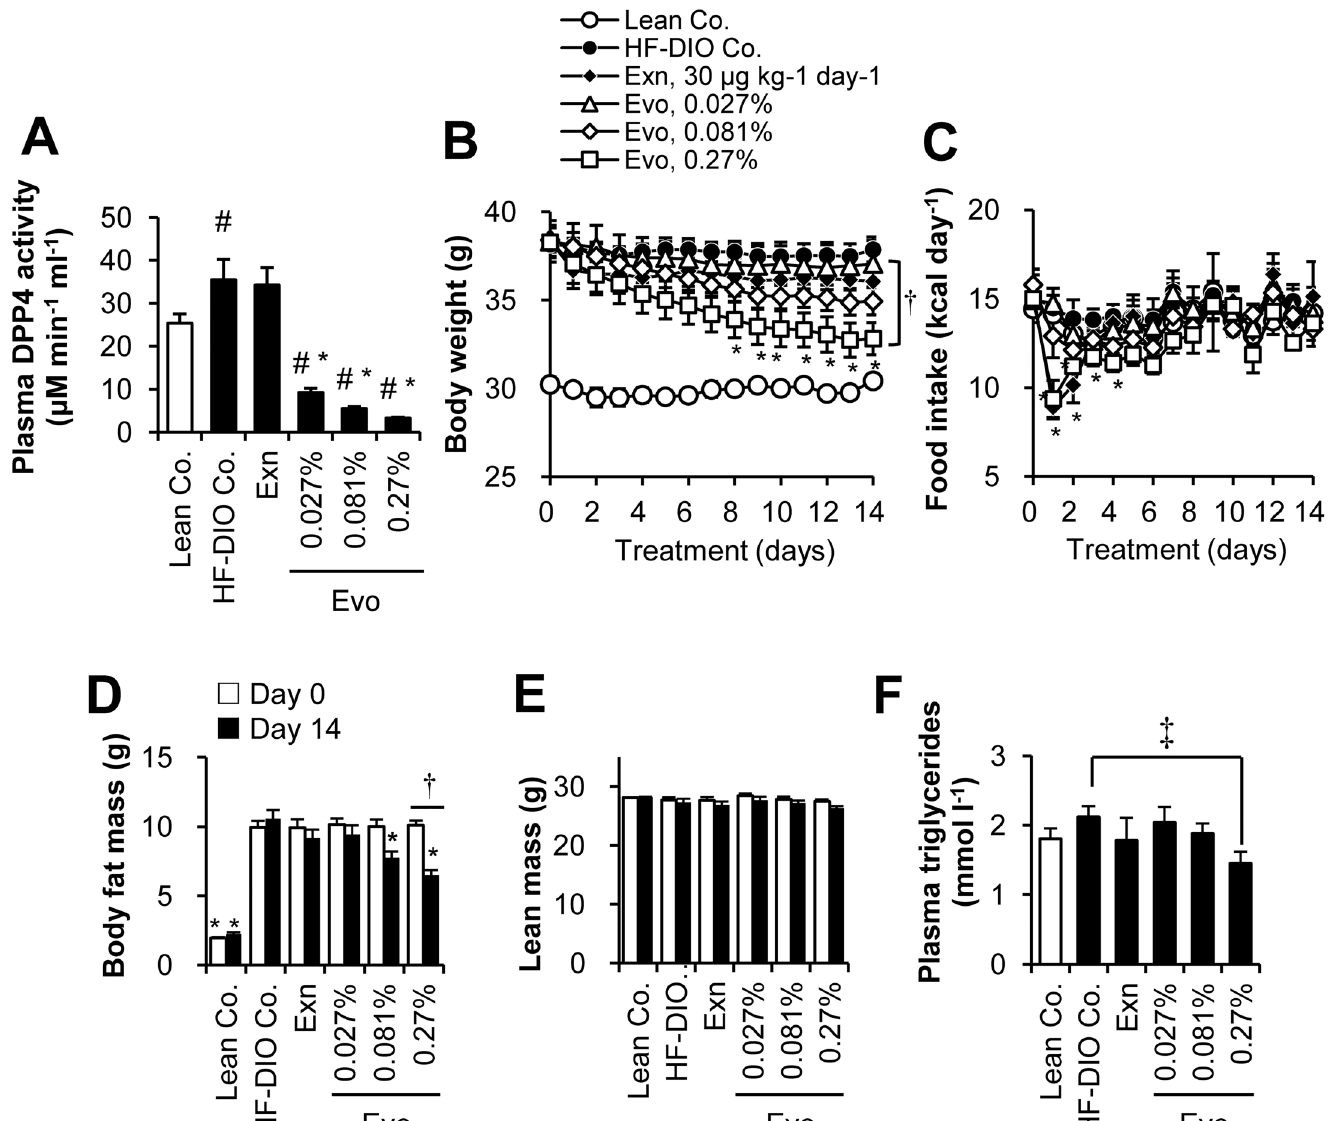
Fig 2. Two-week treatment of evogliptin decreased whole body fat mass in obese mice. After HF-DIO mice were treated with exenatide (30 μ g kg -1 , once daily, s.c.) or evogliptin at 0.027%, 0.081%, or 0.27% (w/w) for 2 weeks, (A) plasma DPP4 activity, (B) body weight, (C) energy intake, (D) whole body fat mass, (E) lean body mass, and (F) plasma triglycerides levels were determined (n = 8/group). #, P < 0.05 vs. lean control and * , P < 0.05 vs. HF-DIO control by one-way ANOVA; † , P < 0.05 vs. the baseline by RM two-way ANOVA; ‡ , P < 0.05 vs. HF-DIO control by Student ’ s t